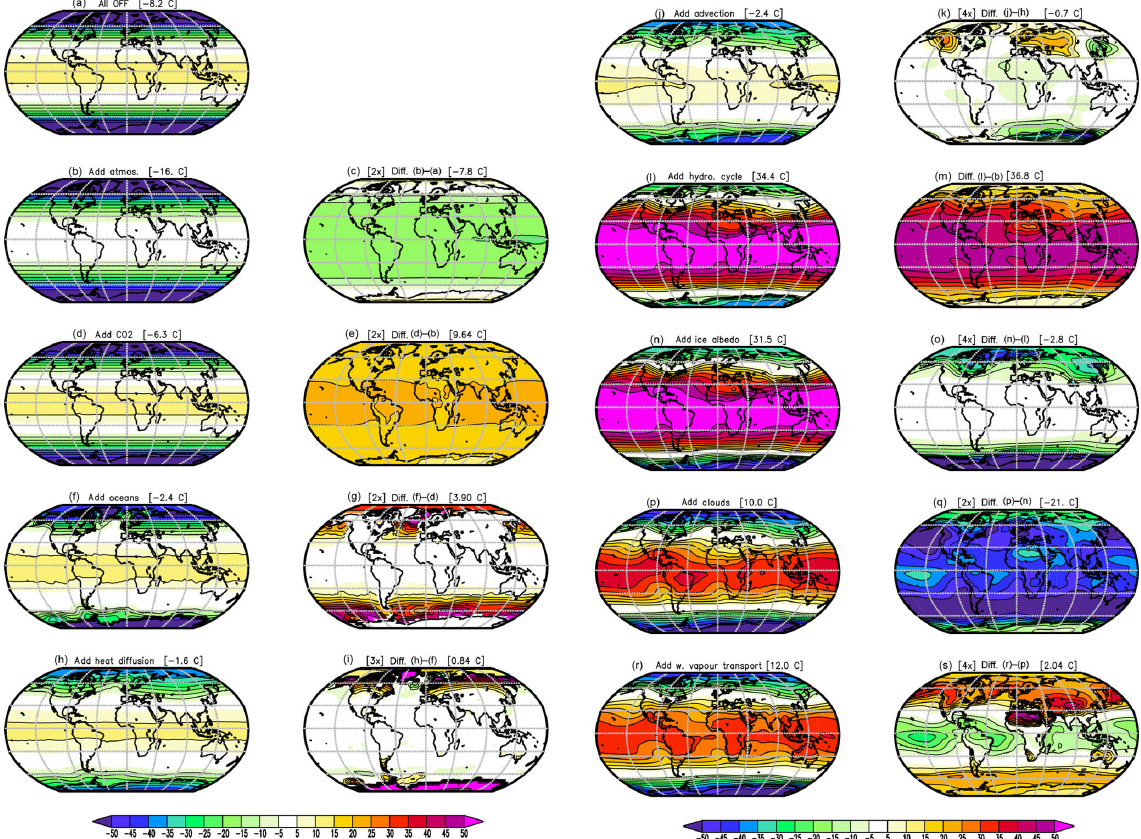
Figure 8. Conceptual build-up of the annual mean climate starting with all processes turned OFF (a) and then adding more processes in each row: (b) atmosphere, (d) CO 2 , (f) oceans, (h) heat diffusion, (j) heat advection, (l) hydrological cycle, (n) ice albedo, (p) clouds, and (r) water vapour transport. Each panel in the second and fourth columns shows the difference between the panel to its left and the preceding panel. Global mean values are shown in the heading. All values are in degrees Celsius ( ◦ C). In some panels the values are scaled for better comparison: (e) , (g) , and (q) by a factor of 2; (i) by a factor of 3; and (k) , (o) , and (s) by a factor of 4. For details on the experiments, see Sect.